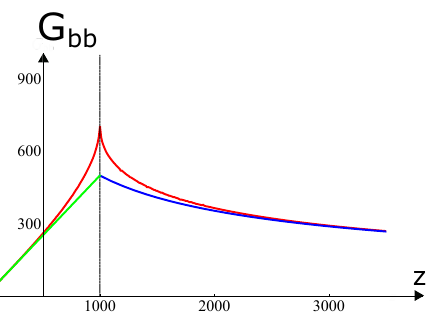
Figure 5 . Red: zero-temperature or zero-energy M = 0 bulk two-point function G = 1000, t = 1 and C = 1 / 2. The initial decay close to the lightcone singularity is of z for z (cid:30) logarithmic (2.20). Blue: power law (inverse square-root) behavior at z (linear) behavior at z z (cid:30) (cid:30)